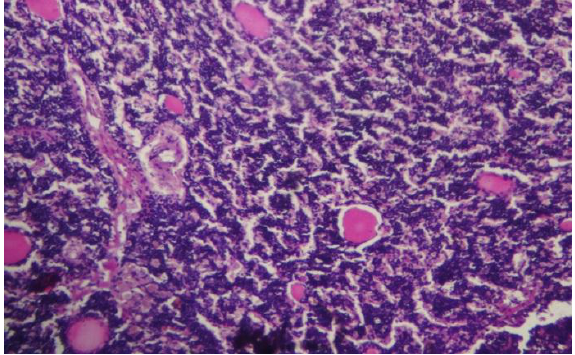
Figure, 1: Head of kidney in fish scattered follicles of thyroid gland filled with homogenous colloid. Notice the absence of connective tissue capsule (10X PAS).